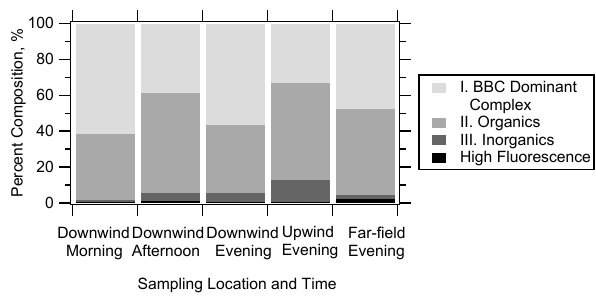
Figure 9. Fig. 9. Chemical classification of sampled